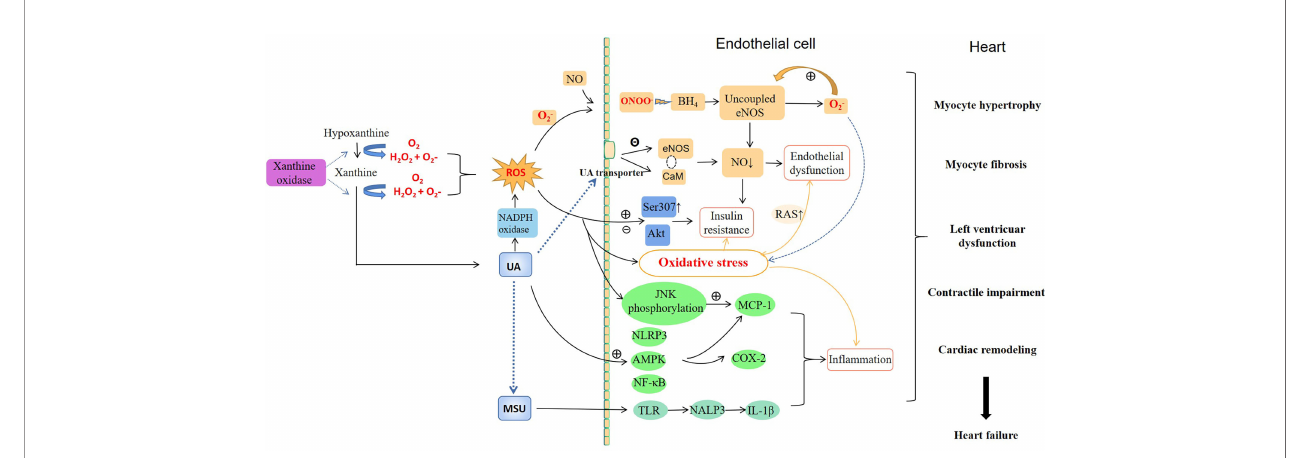
FIGURE 1 | Potential mechanisms by which hyperuricemia might mediate